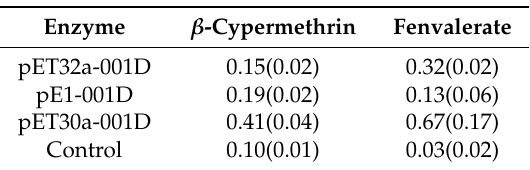
Specific activities of purified fusion carboxylesterases expressed in E. coli towards pyrethroid